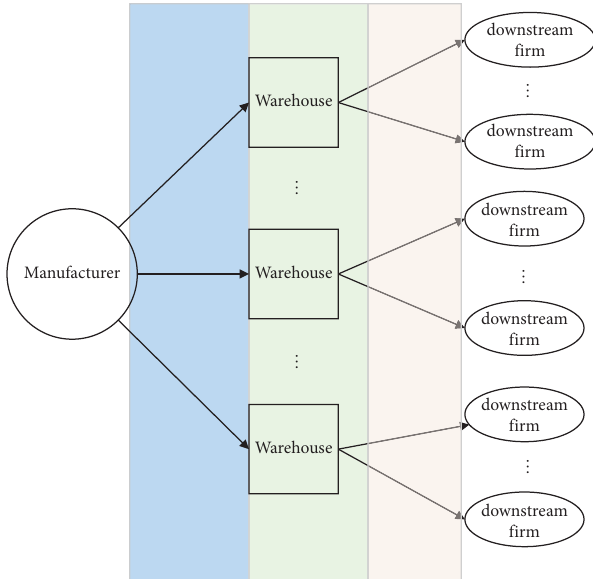
Figure 1: Dynamic structure of the downstream discrete